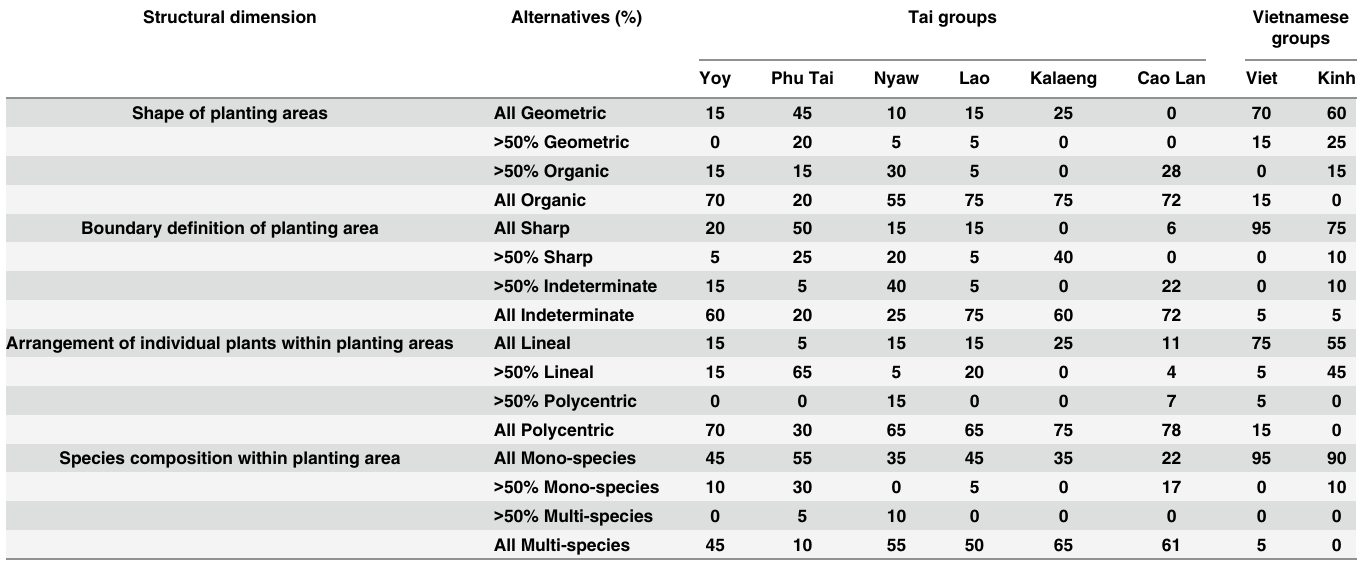
Table 2. Comparison of horizontal structural characteristics of homegardens of different ethnic groups in Northeast Thailand and Vietnam (% of gardens displaying characteristic) (n = 20, except 17 for Cao Lan). Structural dimension Alternatives (%)